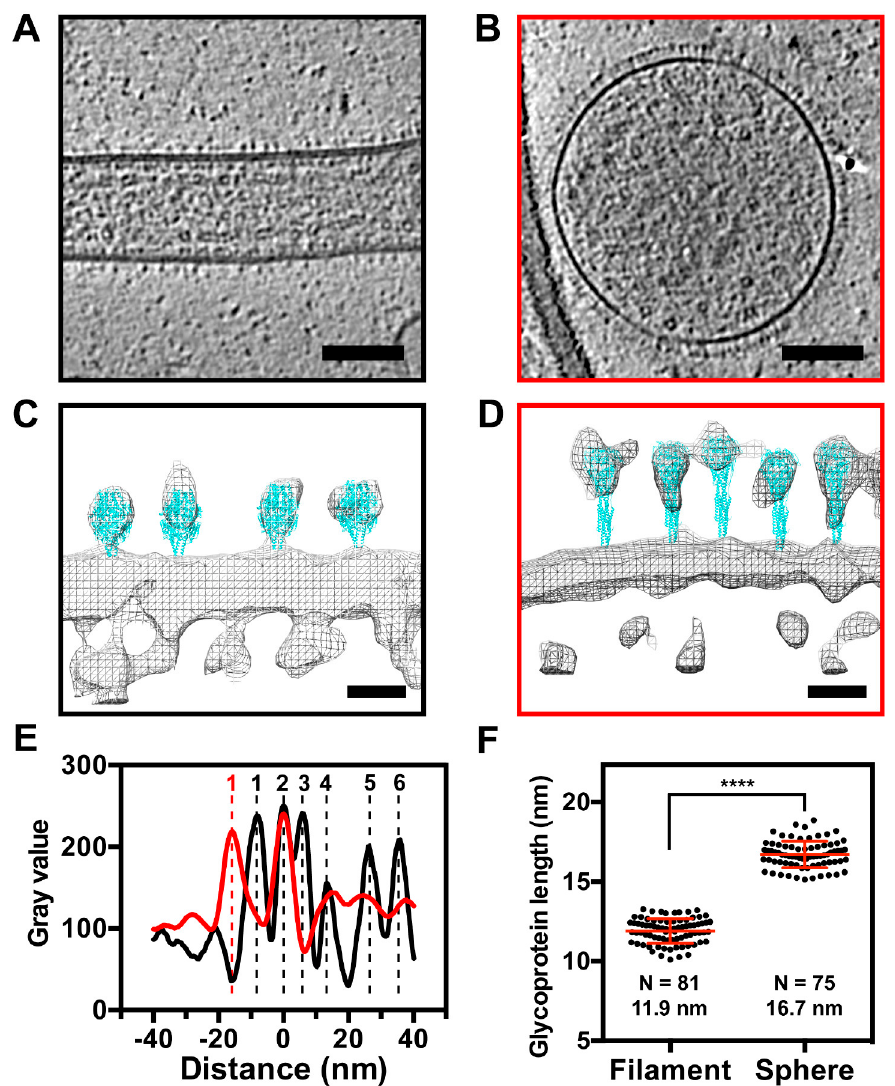
Figure 7. Structural comparison between filamentous and spherical RSV particles. ( A , B ) Representative tomographic slices of a filamentous ( A , black outline) and spherical ( B , red outline) particle. ( C , D ) Model fitting of representative regions of the isosurface rendering of the tomographic data for filamentous ( C , black outline) and spherical ( D , red outline) particles. Prefusion F (PDB ID: 4JHW) and postfusion F (PDB ID: 3RRT) were used for ( C ) and ( D ), respectively. ( E ) Linear density profiles of a filamentous particle (black line) and spherical particle (red line). Density peaks 1 through 6 represent: 1, Viral glycoproteins; 2, Viral membrane; 3, Matrix; 4, M2-1; 5 and 6, RNP. ( F ) Glycoprotein length quantification from filamentous and spherical particles. **** indicates the student t -test p -value is below 0.0001. Scale bars are 100 nm ( A , B ) and 10 nm ( C , D ).